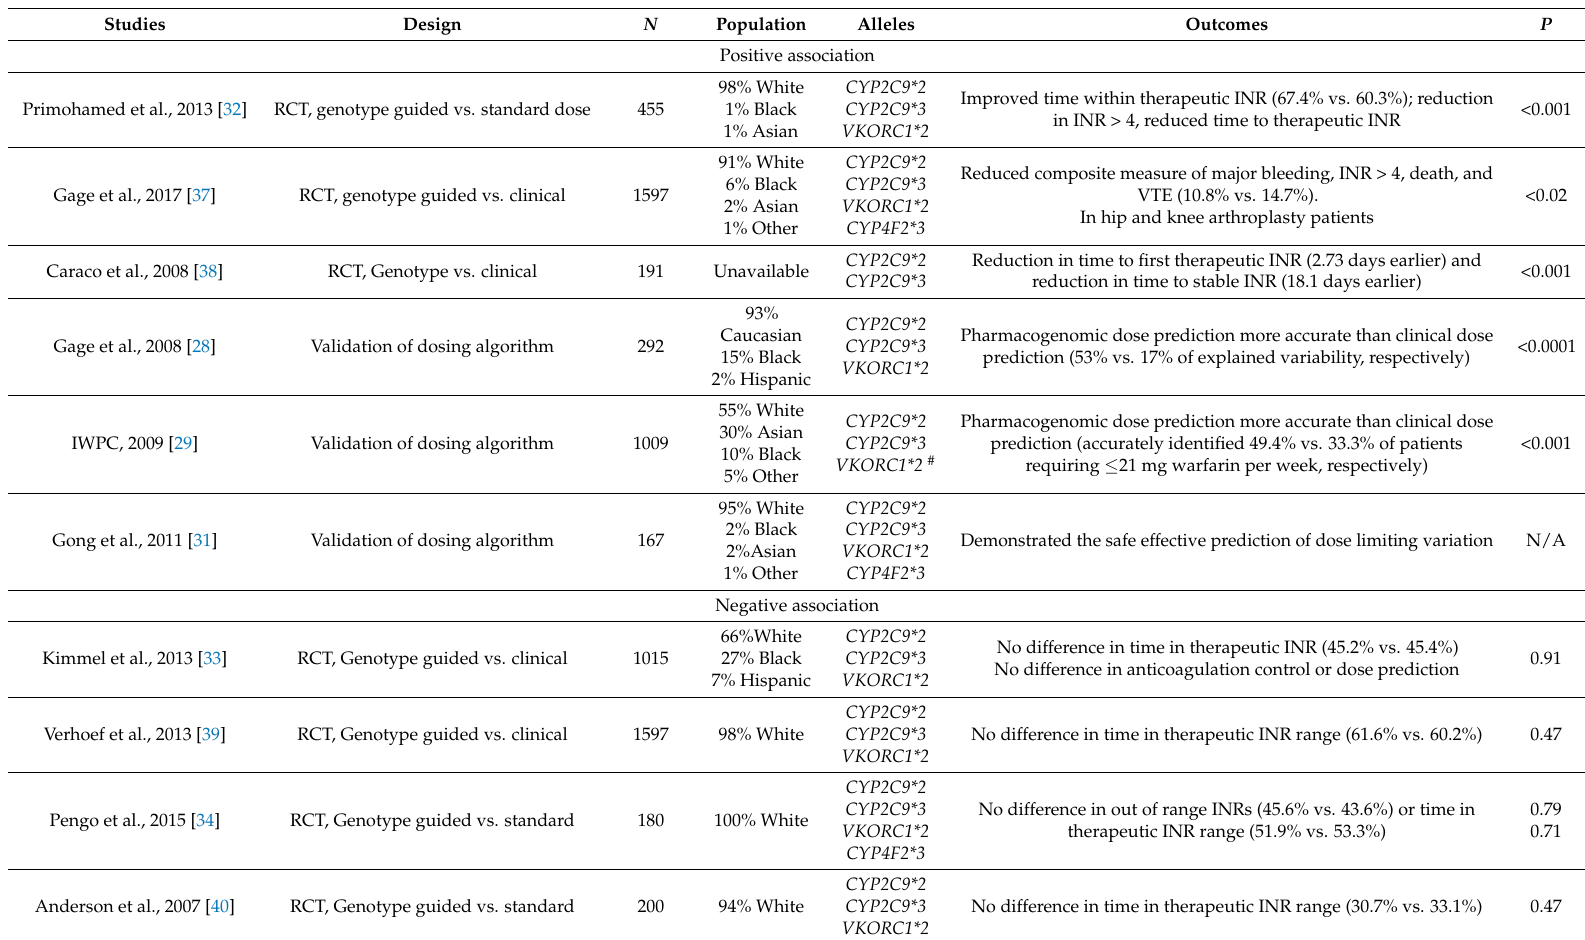
Table 1. Association of pharmacogenomics with warfarin